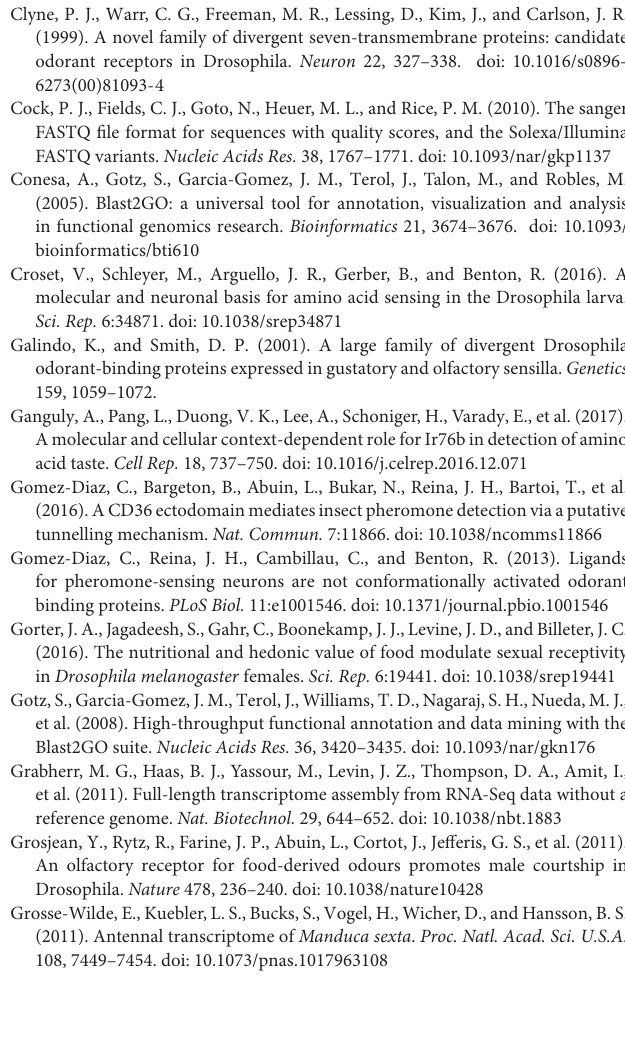
FIGURE S1 | Transcriptome overview of O. chinensis antennae. (A) Unigenes annotated through different databases. (B) Gene ontology (GO) classification of the O. chinensis unigenes. FIGURE S2 | The amino acid alignment of the predicted classic OBPs. FIGURE S3 | The amino acid alignment of the predicted atypical OBPs. FIGURE S4 | The amino acid alignment of the predicted plus-C OBPs type-A. FIGURE S5 | The amino alignment of the predicted plus-C OBPs type-B. FIGURE S6 | The amino alignment of the predicted CSPs. TABLE S1 | List of OBPs, CSPs, ORs, IRs, and SNMPs in Orthopteran species. TABLE S2 | A list of the identified OBPs, CSPs, ORs, IRs and SNMPs in O. chinensis , and detailed genetic characteristics, best matches in NCBI-nr database, protein domains and estimated expression levels found in each petal module. TABLE S3 | The amino acid sequences used for phylogenetic analyses.